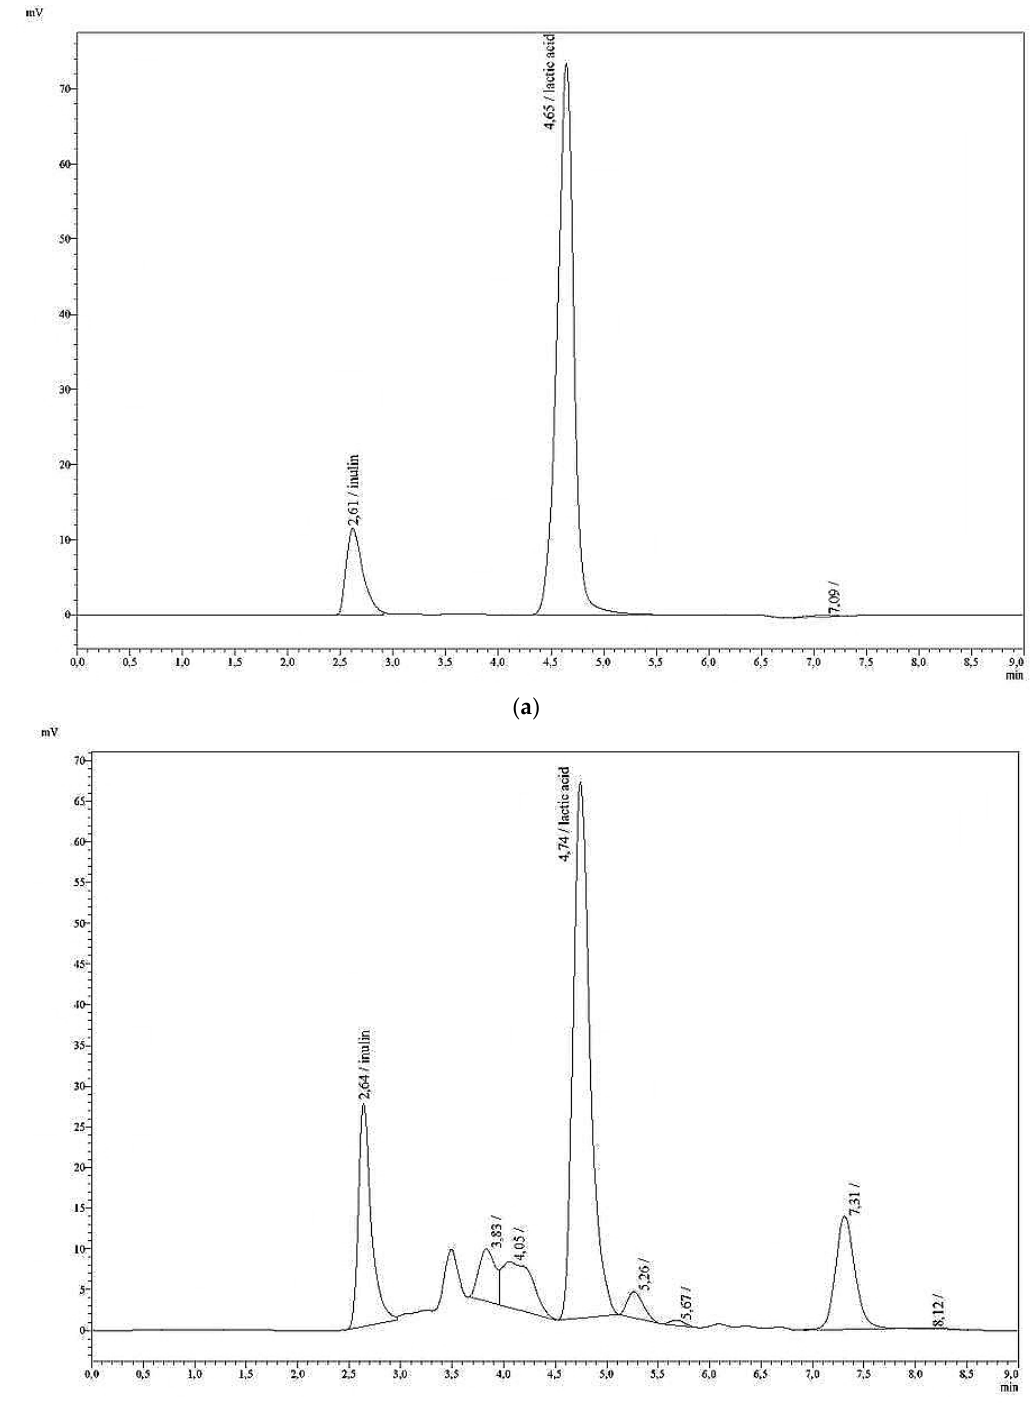
Figure 3. Separation of inulin in a Polypore H column at 80 °C, with a RID and 0.01 N sulphuric acid as the eluent; ( a ) standard solution with lactic acid; and ( b ) aqueous grass silage extract. For the detection of fructans, inulin was used as a representative compound of this sugar group.